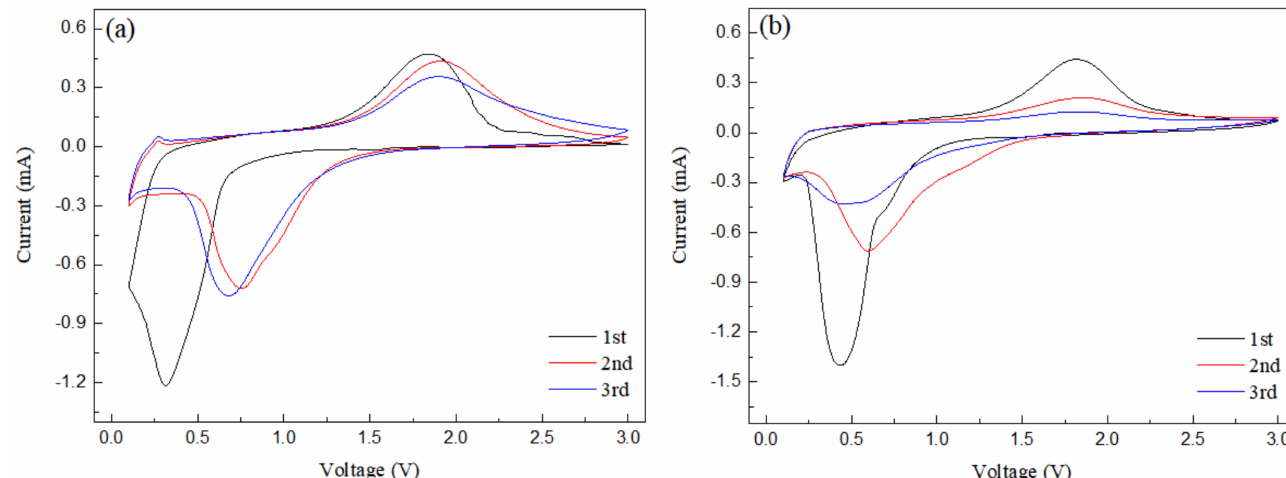
Figure 7. Cyclic voltammetry curves of ( a ) Fe 2 O 3 -175 ◦ C; ( b ) 0.2rGO/Fe 2 O 3 -175 ◦